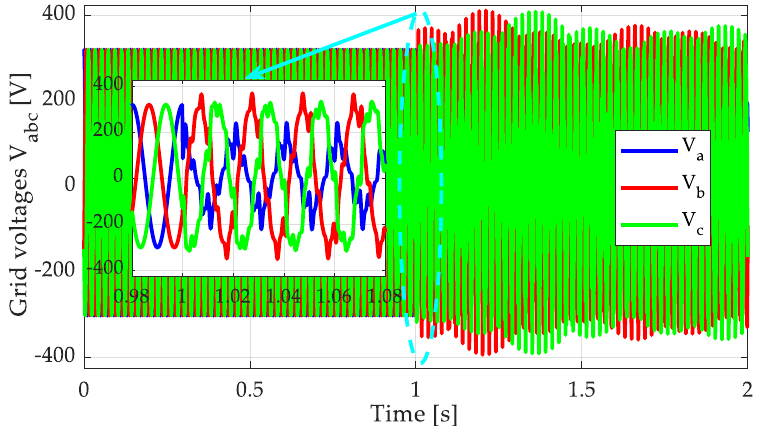
Figure 18. Grid voltages: scenario 3.